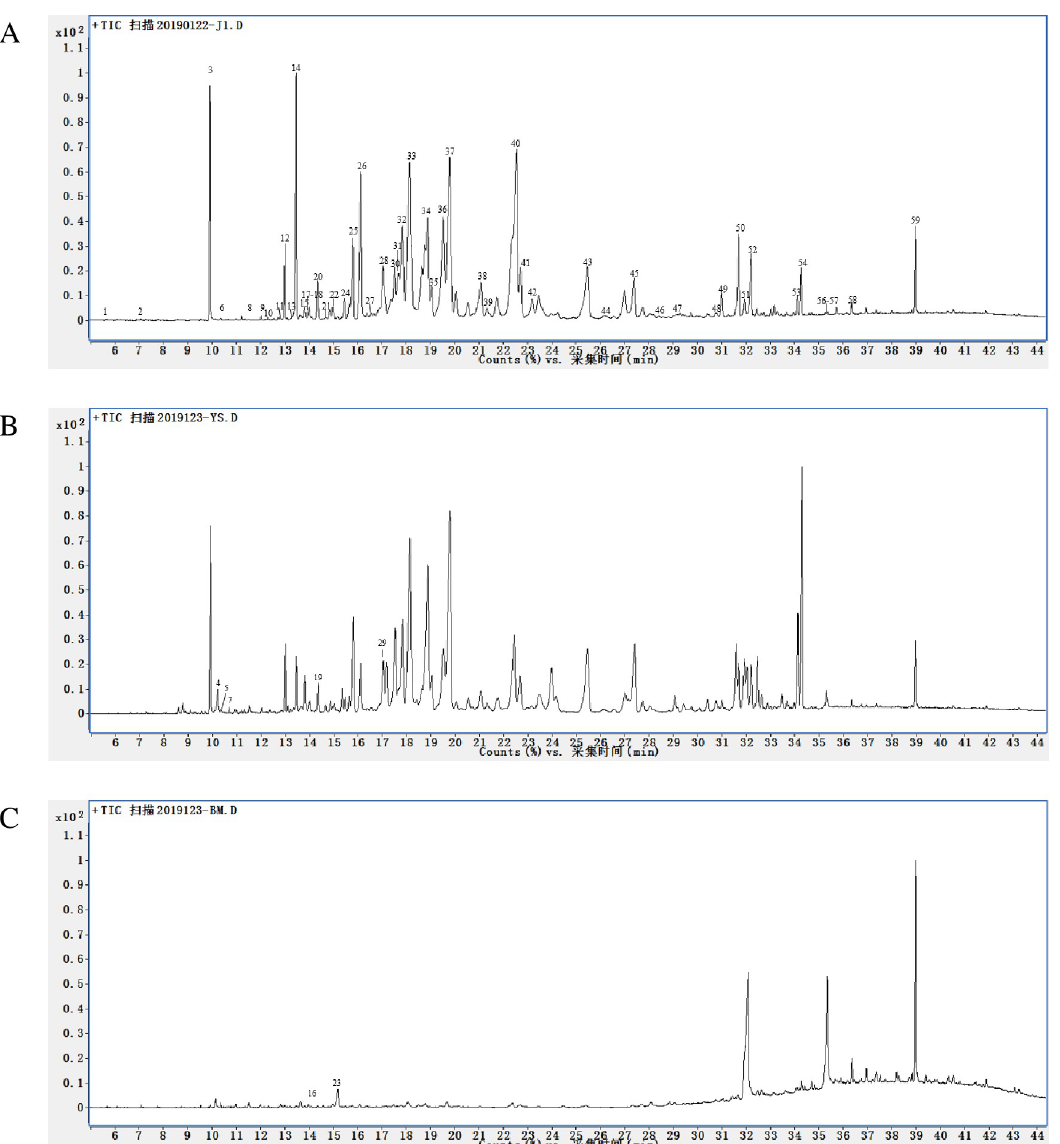
Fig 9. GC chromatograms of the three essential oils in the brown zone (B), wild agarwood (W), and healthy zone (H).